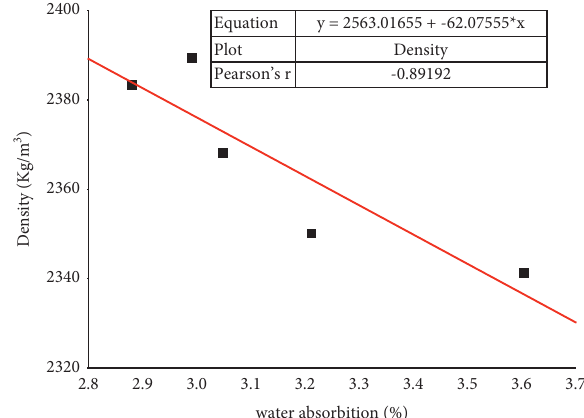
Figure 5: Regression analyses of concrete density and water absorption.